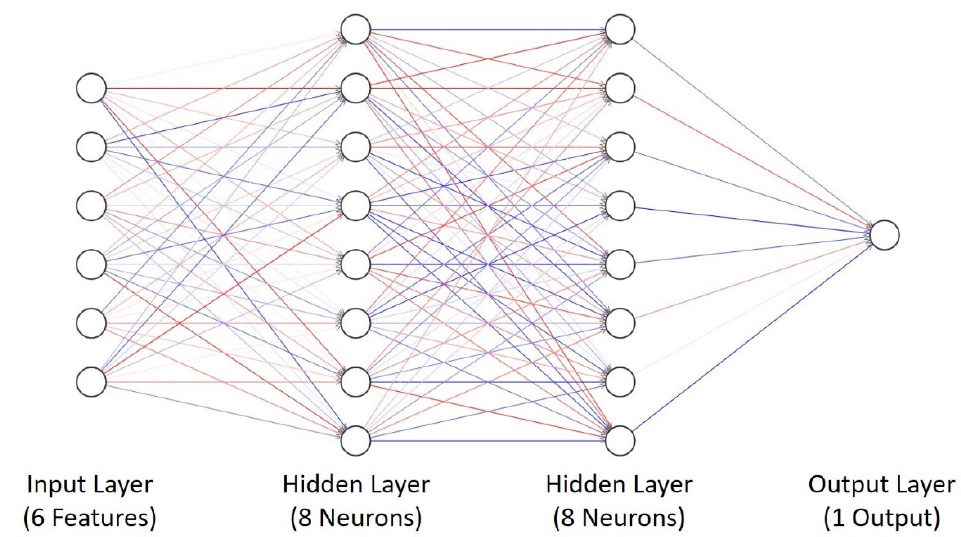
Figure 7. Structure of NN Implemented for 6 Features and 1 Output with 2 Hidden Layers Each Containing 8 Number of Neurons.